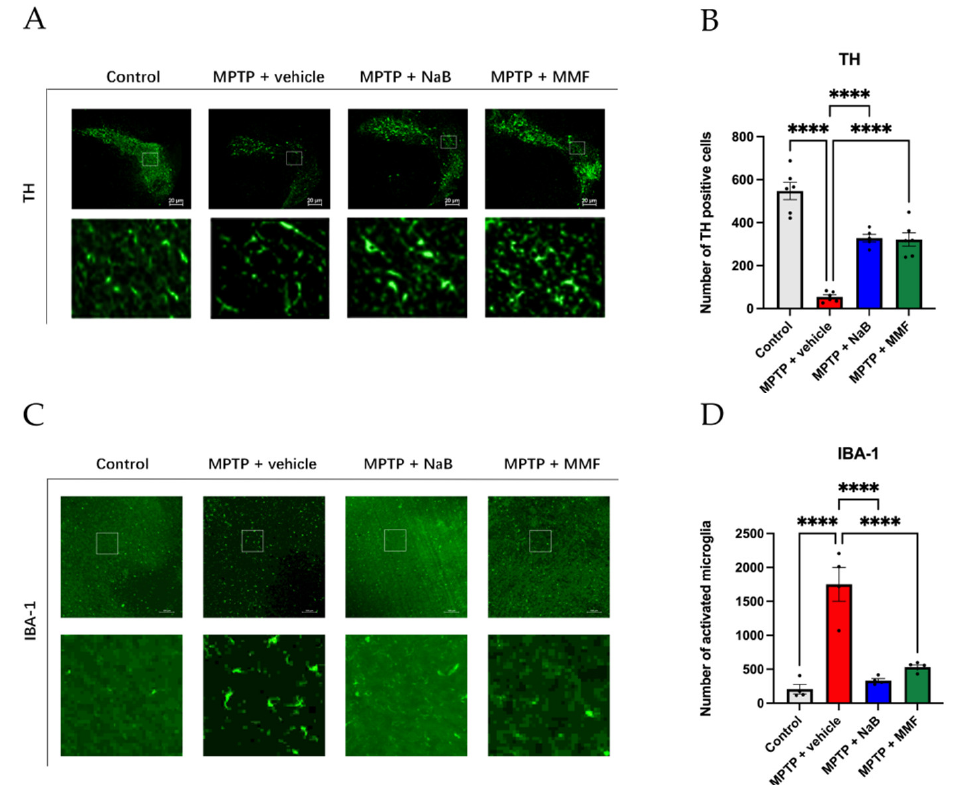
Figure 5. NaB and MMF restore TH levels in PD mice. ( A ) Representative immunofluorescence staining for TH (green). There is a 20 μm scale bar. ( B ) Treatment with NaB and MMF alleviates the reduction of TH+ dopaminergic neurons compared with the MPTP + vehicle group. (n = 5–6). ( C ) Representative immunofluorescence staining for IBA-1 (green) in SNpc. There is a 100 μm scale bar. ( D ) The number of activated microglia was reduced in MPTP + NaB and MPTP + MMF groups compared with the MPTP + vehicle group. (n = 4–5). Data are presented as mean ± SEM. **** p < 0.0001 versus the MPTP + vehicle group.